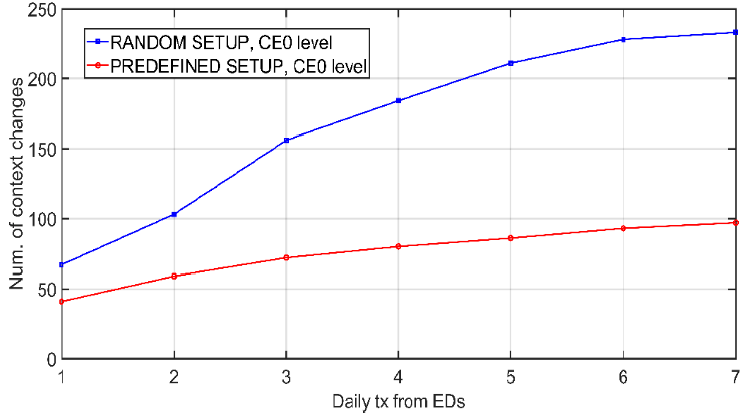
Figure 8. Number of link switches as a function of daily data rate.